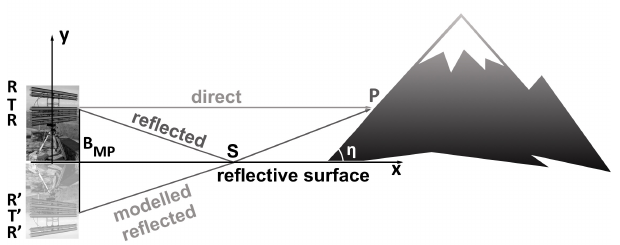
Figure 4. Radar imaging geometry similar to Lloyd’s mirror experiment [22]. T and R is the location of the transmit and receive radar antenna, T’ and R’ the virtual transmit and receive radar antennas, which are the mirror of T and R with the reflective surface. B MP is the multipath baseline that determines the MPI pattern frequency. It is approximately double the distance between the antenna and the reflective